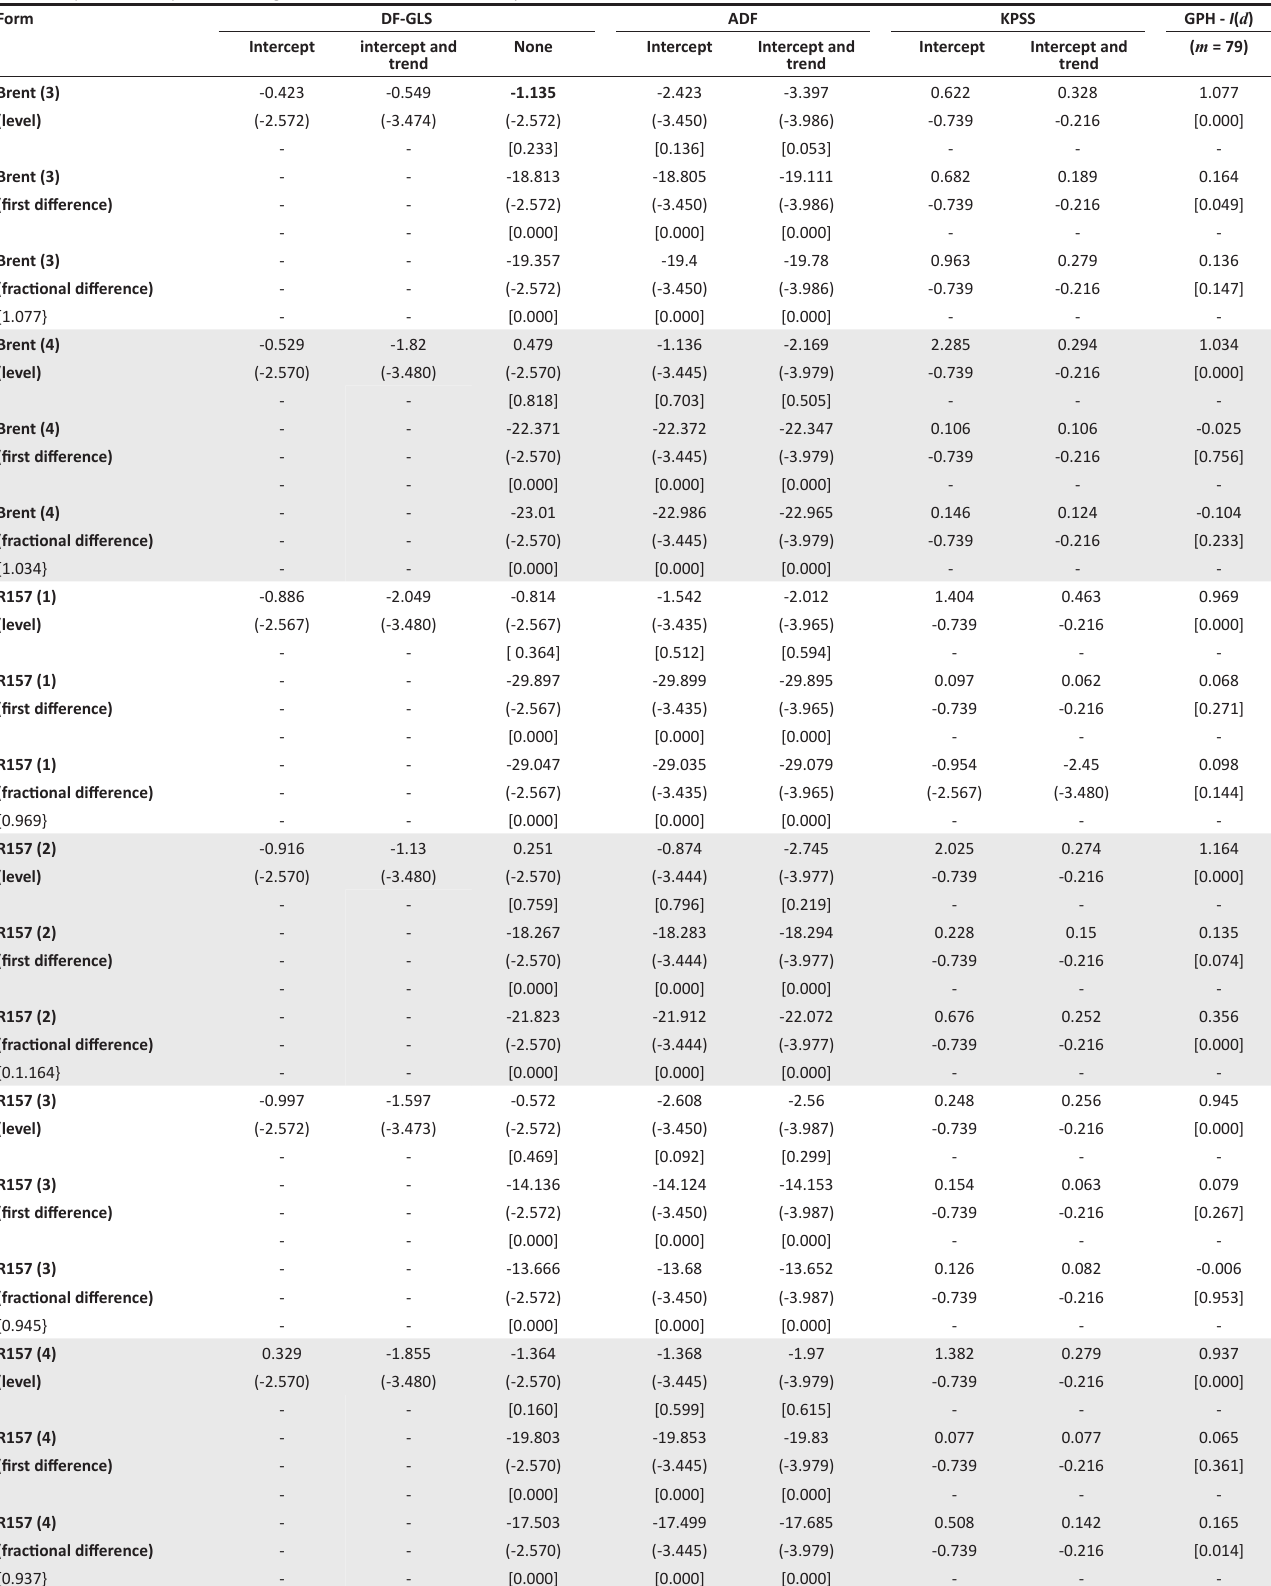
TABLE A1 (Continues...): Determining the correct form of stationarity.